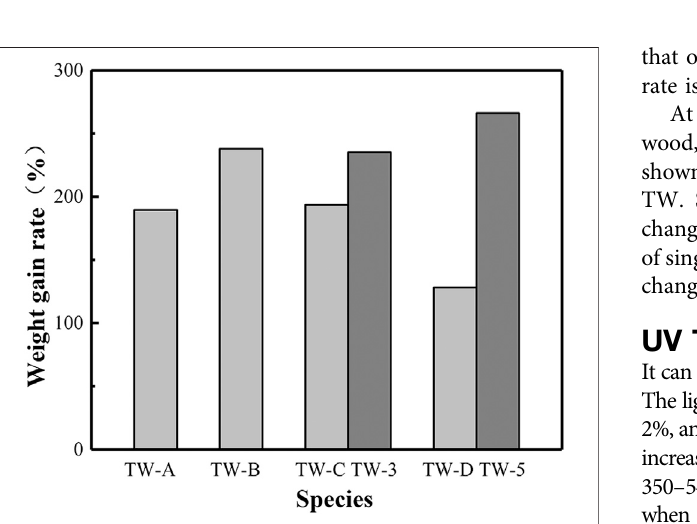
FIGURE 8 | The histogram of weight gain rate of each